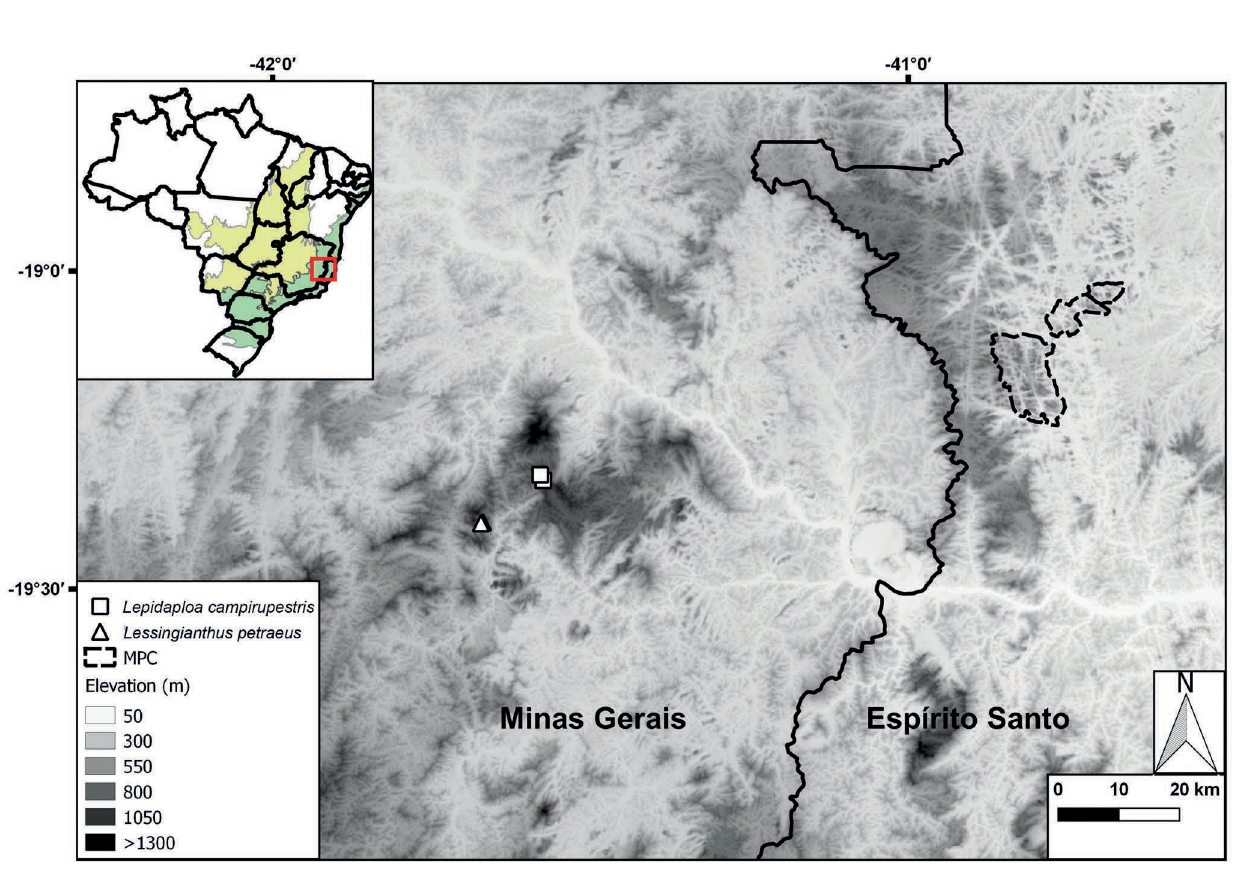
Figure 3 – Distribution of Lessingianthus petraeus Antar & Loeuille and Lepidaploa campirupestris Antar & Loeuille. MPC: Monumento Natural dos Pontões Capixabas, a Federal Protected Area. In the inset map, the yellow area shows the extension of the Cerrado domain and the green area shows the extension of the Atlantic Forest domain. Map created with QGIS v.3.0.1 (QGIS Development Team